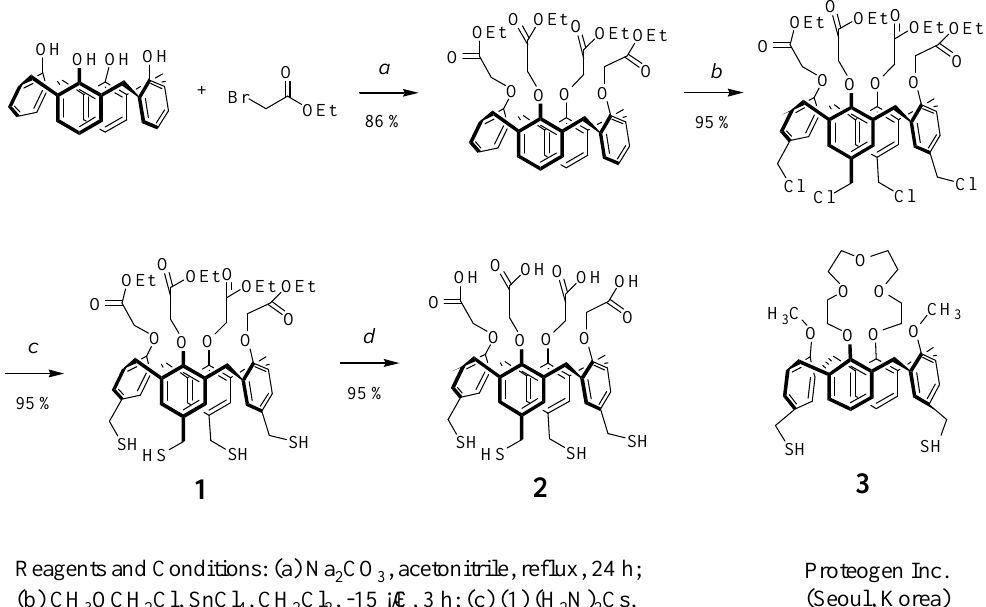
Figure 1 . Synthetic scheme and structure of Cal-4 derivative 1, 2 and 3